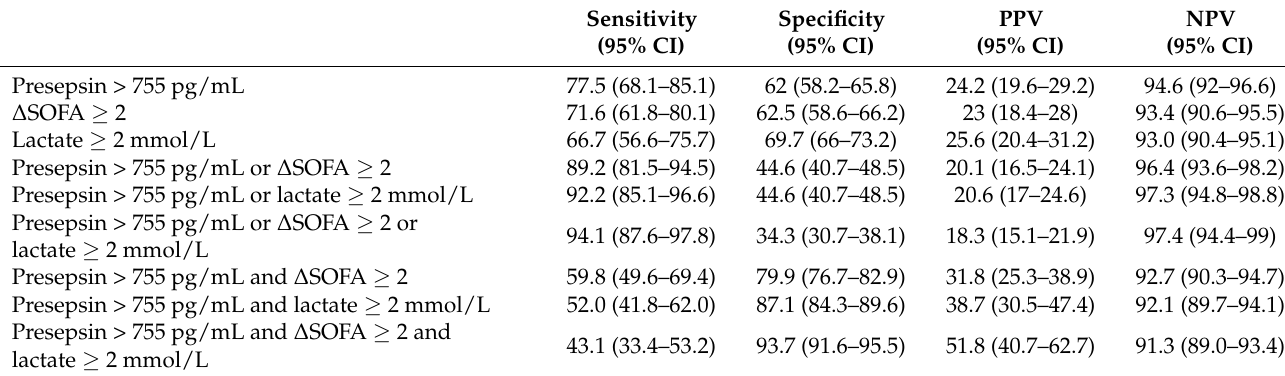
Table 3. Prognostic accuracy of presepsin > 755 pg/mL, delta SOFA score ≥ 2 points, and lactate ≥ 2 mmol/L for predicting 28-day mortality.